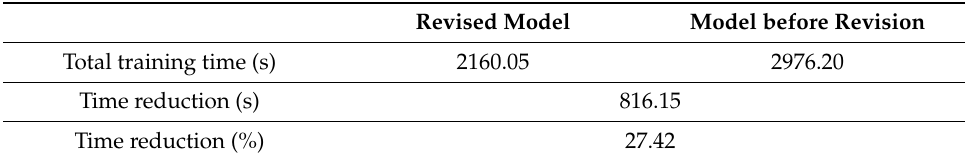
Table 6. Comparison table for training